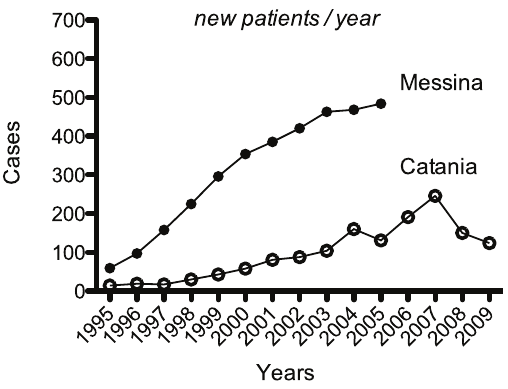
Figure 2. Number of the Hashimoto’s thyroiditis patients in the cohorts from Catania and Messina. In this and subsequent figures, data from the Messina cohort are from ref. 6.